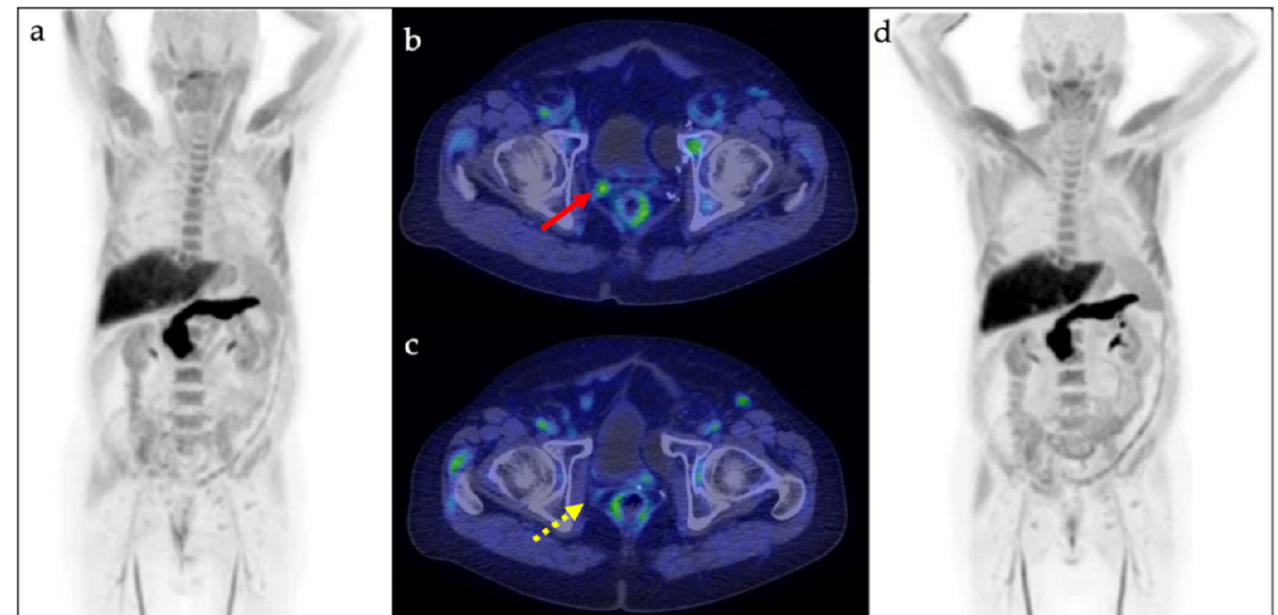
Figure 4 . Impact of [ 18 F]Fluciclovine PET/CT scan on clinical management of the PCa patients. ADT, androgen deprivation therapy.